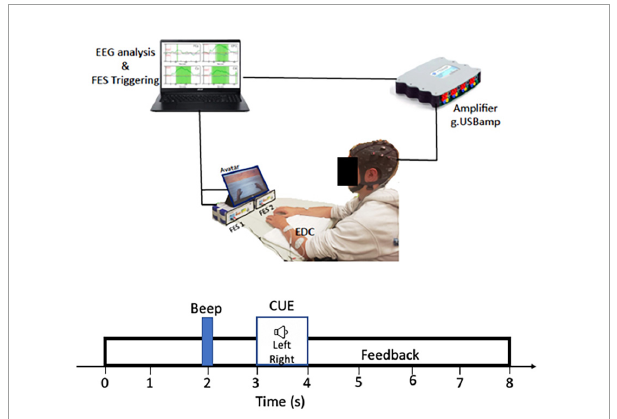
FIGURE1 RecoveriX system set up: Participants were seated comfortably with arms positioned flat on a table directly in front of them. Functional electrical stimulation (FES 1 and FES 2) are g-estim units for left and right EDC electrical stimulation. The main computer controls both the FES triggering and EEG